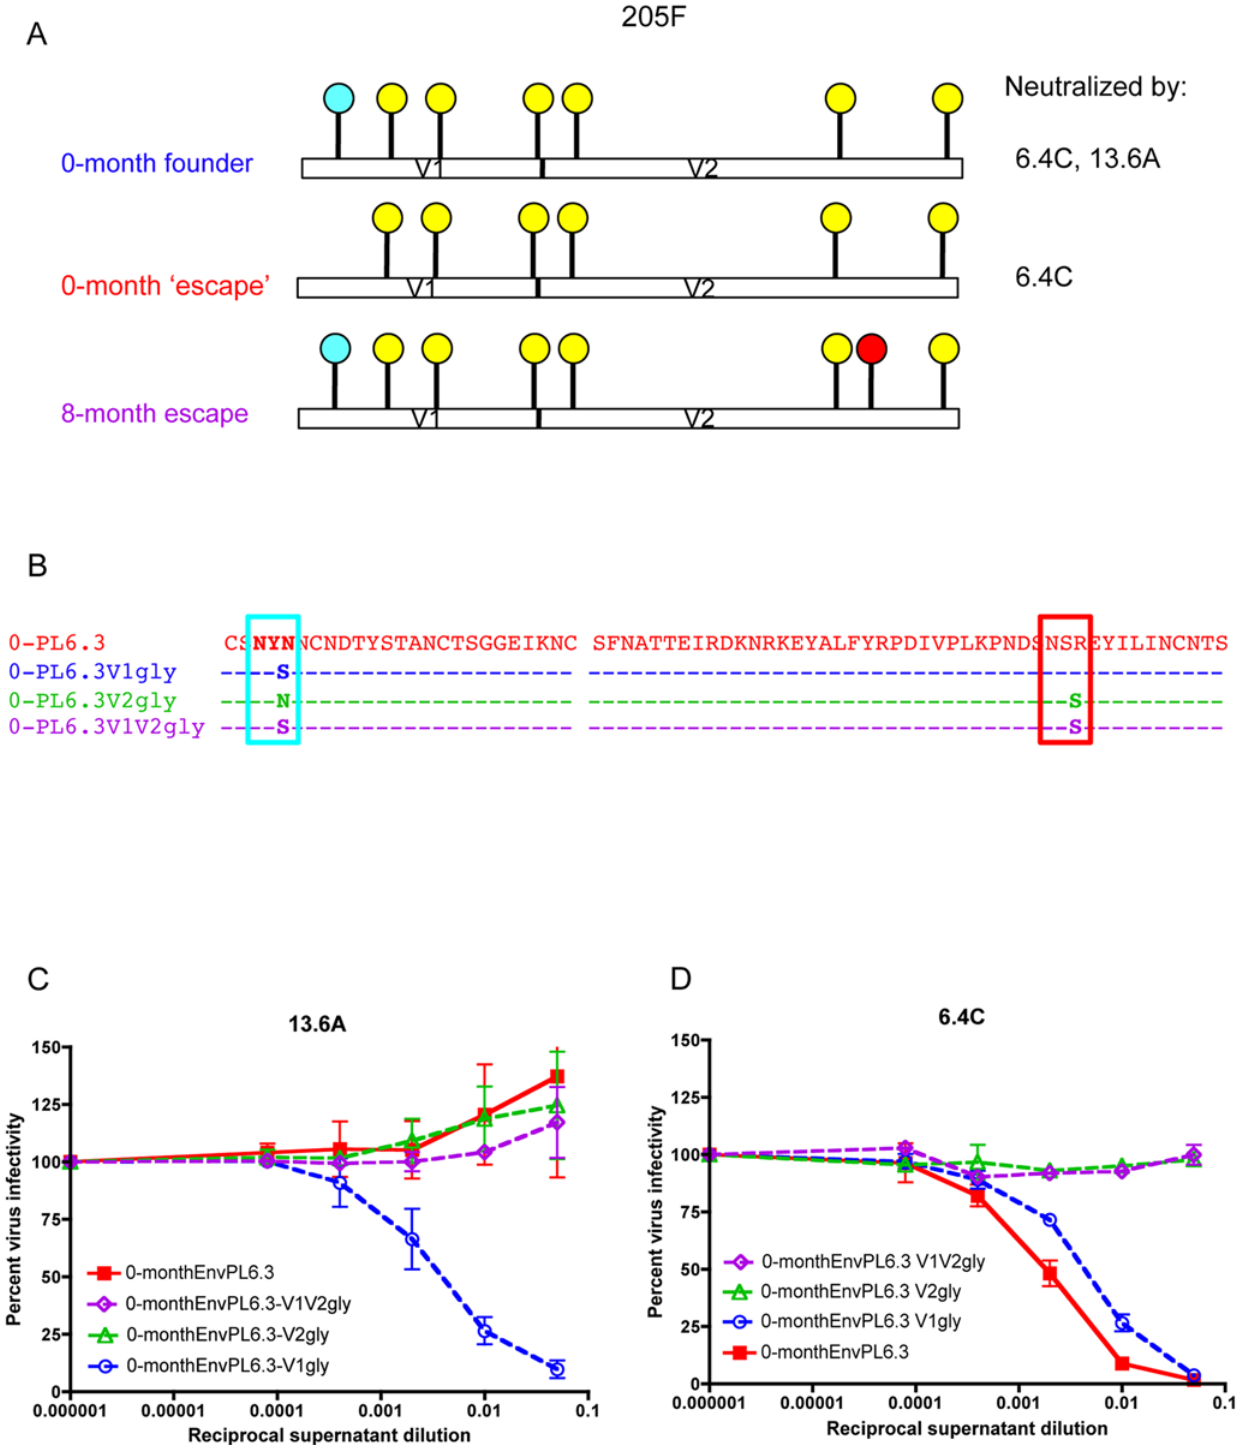
Figure 6. Potential N-linked glycosylation sites in V1 and V2 modulate sensitivity to Mabs. (A) Schematic diagram showing the position of potential N-linked glycans on the V1V2 sequence of the ‘founder’ 0-month Env sequence (inferred from Fig. S6), the 13.6A-resistant 0-month EnvPL6.3, and the 6.4C/13.6A-resistant 8-month EnvPB2.3. The absence of the V1 glycan shown in blue was associated with resistance against 13.6A, while addition of the V2 glycan shown in red was associated with resistance against 13.6A and 6.4C. (B) Potential N-linked glycosylation sites (NXS or NXT where X is any residue except proline) in V1V2 that were introduced singly or in combination into EnvPL6.3 are shown in blue (V1) or red (V2). The text color corresponds to the graphs in (C and D) . 0-month EnvPL6.3 naturally lacks both sites. Neutralization of 0-month EnvPL6.3 and the site- directed mutants shown in panel B was evaluated for 13.6A (C) and 6.4C (D) using reduction of luciferase production in JC53-BL13 cells. Percent virus infectivity is plotted against the log10 reciprocal dilution of hybridoma supernatant. Error bars represent the standard deviation of at least two independent experiments using duplicate wells.